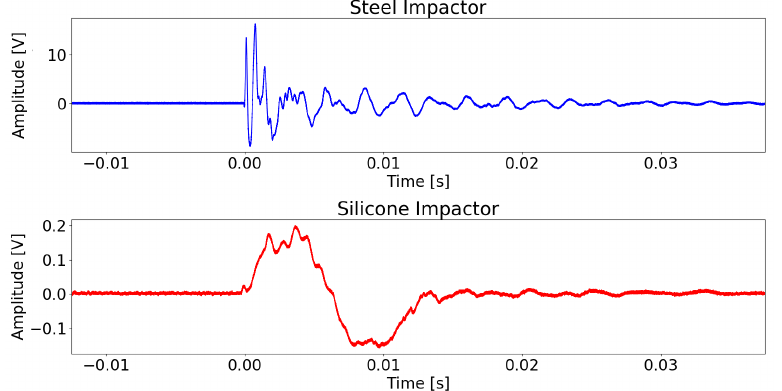
Figure 3. Sensor signal recording for a steel and silicone impactor. All parameters between the two impacts are kept the same, only the impactor material was changed.